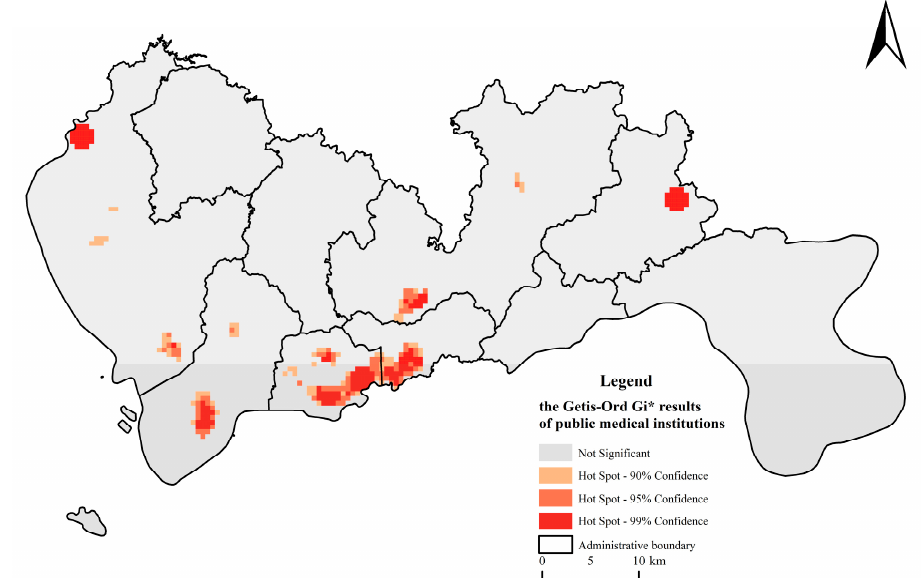
Figure 5. Analysis of cold and hotspots of public medical resources in Shenzhen in 2018.